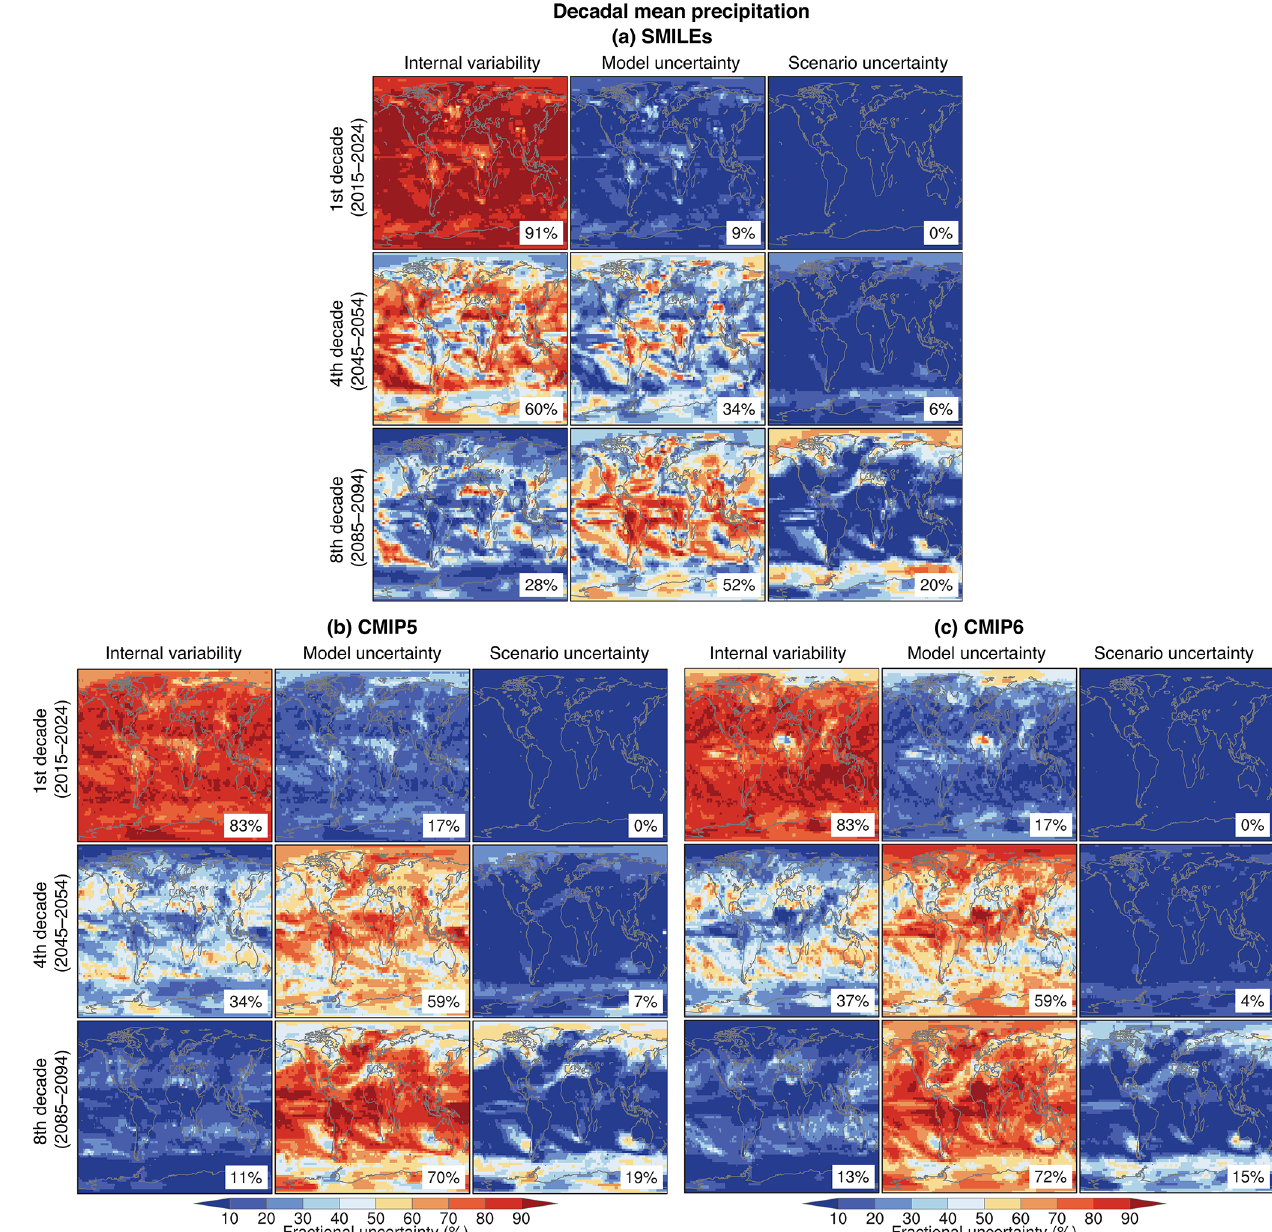
Figure 4. As in Fig. 3 but for precipitation.